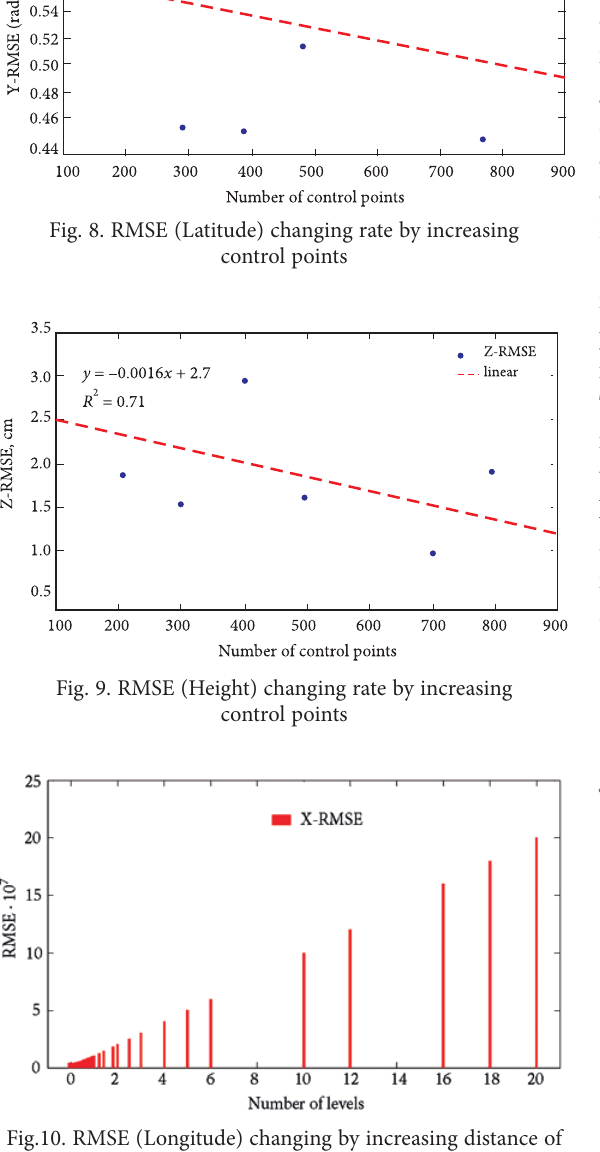
Fig.10. RMSE (Longitude) changing by increasing distance of initial value of point’s height from real value of point’s height